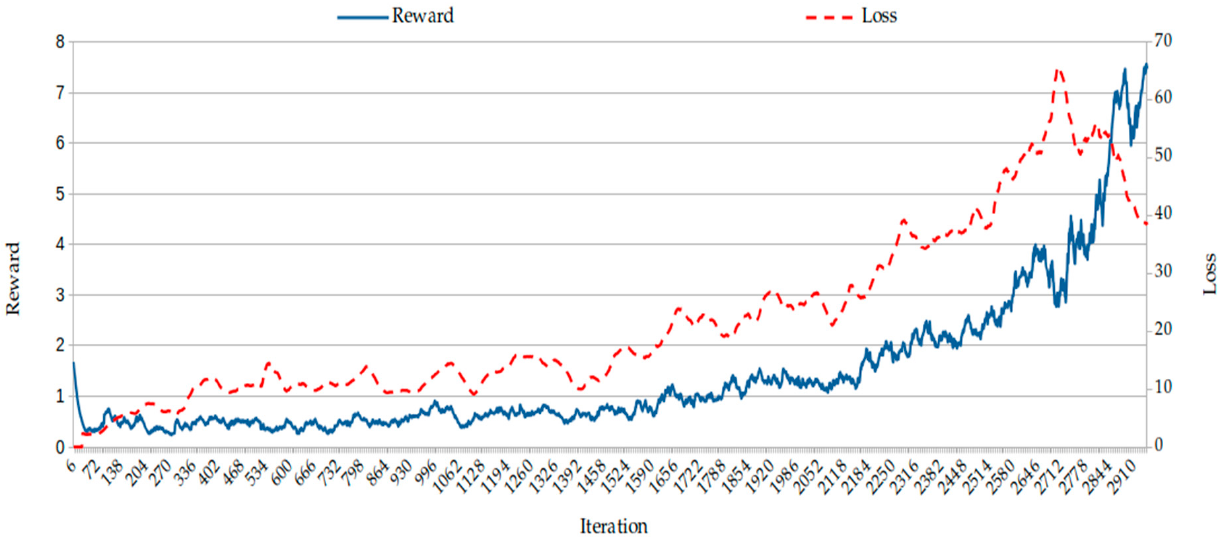
Figure 10. Training in a real environment. Average rewards collected in each trial are shown. Through experience, we found that an average reward of ~7 meant that the agent was able to keep the ball close to the center.